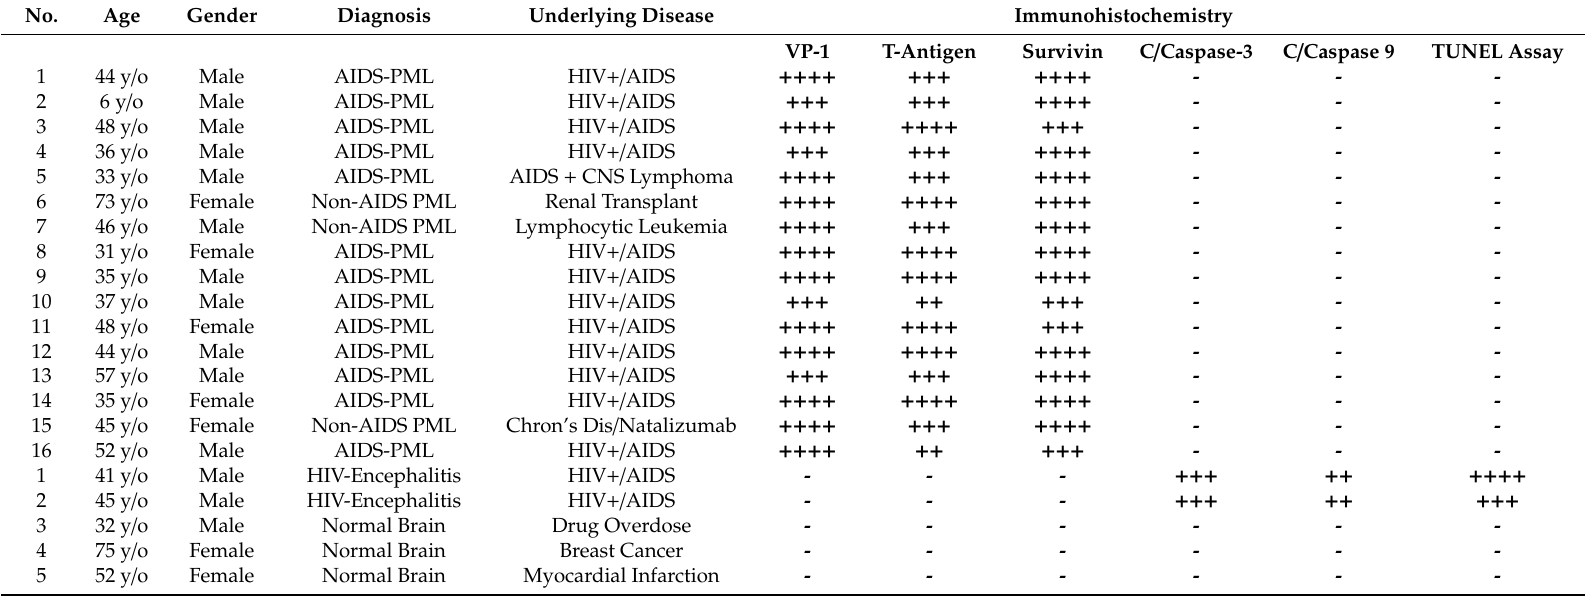
Table 1. Clinical Data and immunohistochemical Results from PML Samples and Controls: Age, gender, diagnosis and associated diseases are listed. Results from immunohistochemistry quantification are shown for viral proteins VP-1 and T-Antigen, and for Survivin, and cleaved caspases 3 and 9, as well as results from